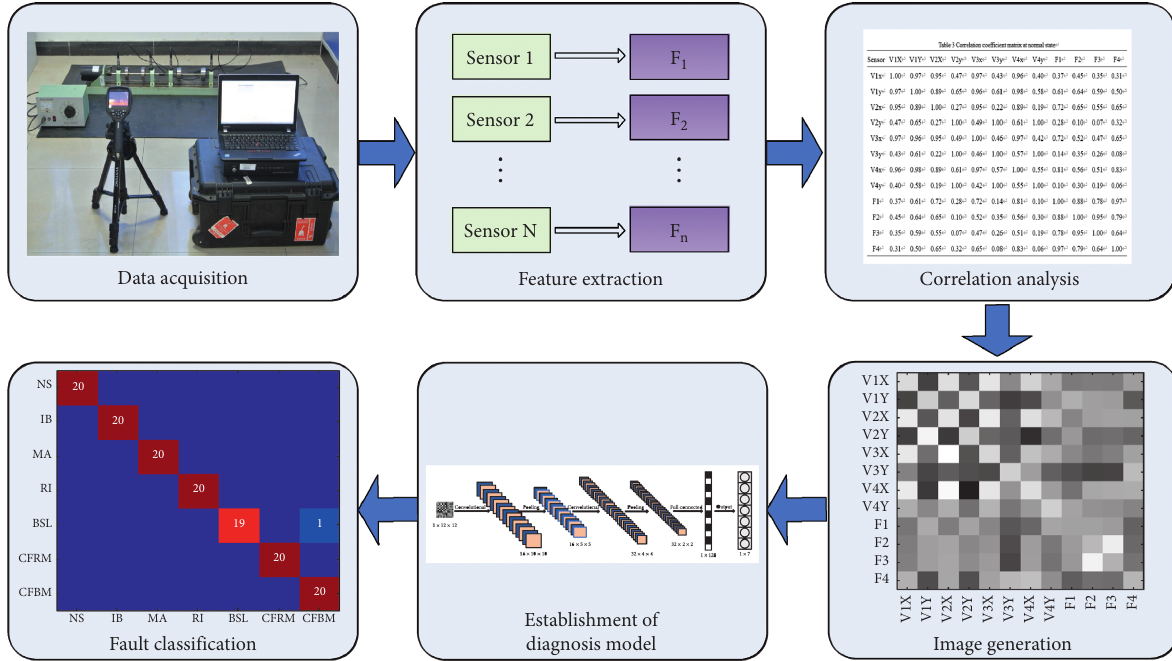
Figure 3: Framework of the proposed